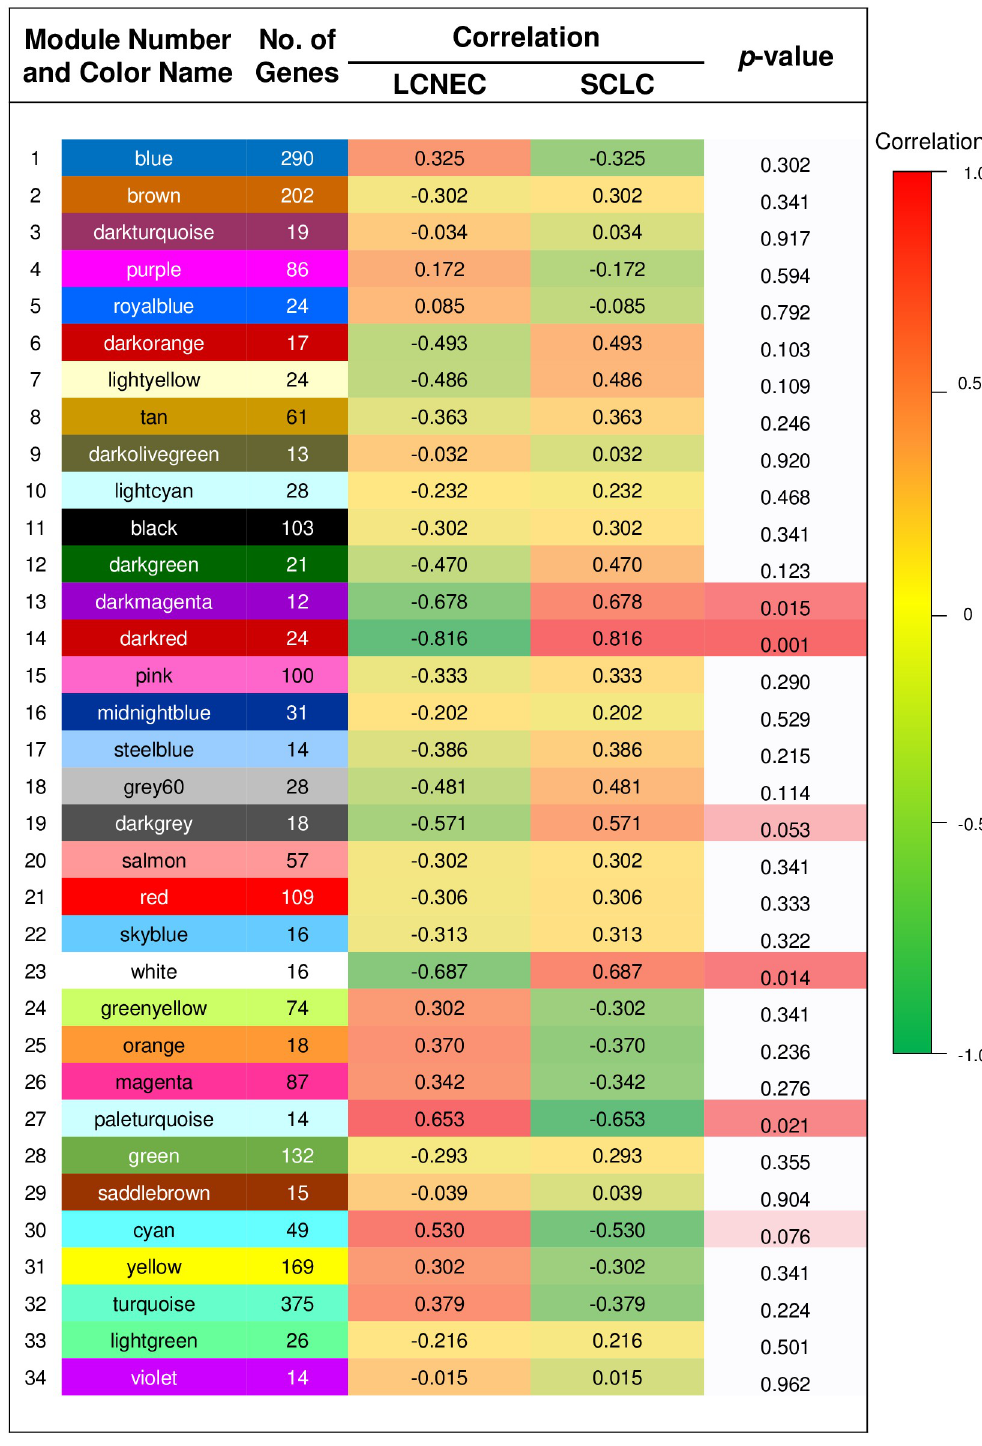
Fig 3. Relationship between consensus module eigengenes and lung neuroendocrine carcinoma subtypes. The first column in the embedded table represents consensus modules, the second column represents the number of eigengenes in each module, the third column indicates the correlations between corresponding module eigengenes to the two lung cancer subtypes (trait), and the last column represents p -values. The module with number and color name is shown on the left side of each cell. The table is color coded by correlation according to the color legend. Intensity and direction of correlations are indicated on the right side of the heatmap (red, positively correlation; green, negatively correlation).